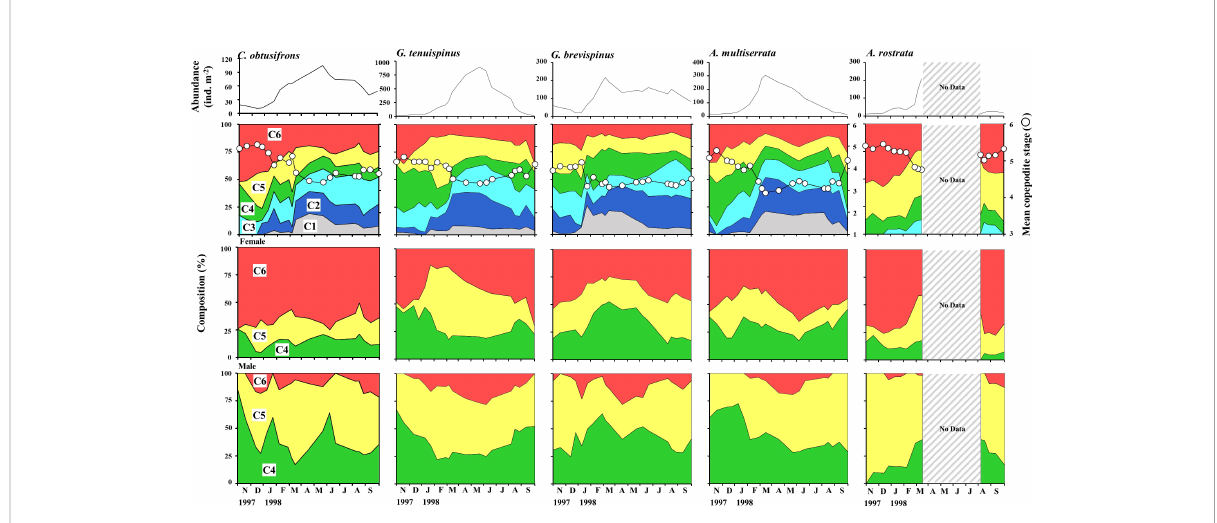
FIGURE 6 Seasonal changes in total abundance, stage composition, and population structure (for C4 – C6) of females and males of the fi ve dominant Aetideidae copepods in the western Arctic Ocean from 27 October 1997 to 29 September 1998. Mean copepodite stage (white circles) was calculated for each species for each sampling date. Populations of A etideopsis rostrata , the deepest dwelling species, were not quanti fi ed between March and August 1998 because zooplankton collection was restricted to the shallower depths related to drifting of the ice station. The shallower dwelling species are Chiridius obtusifrons , Gaetanus tenuispinus , G. brevispinus , and Aetideopsis